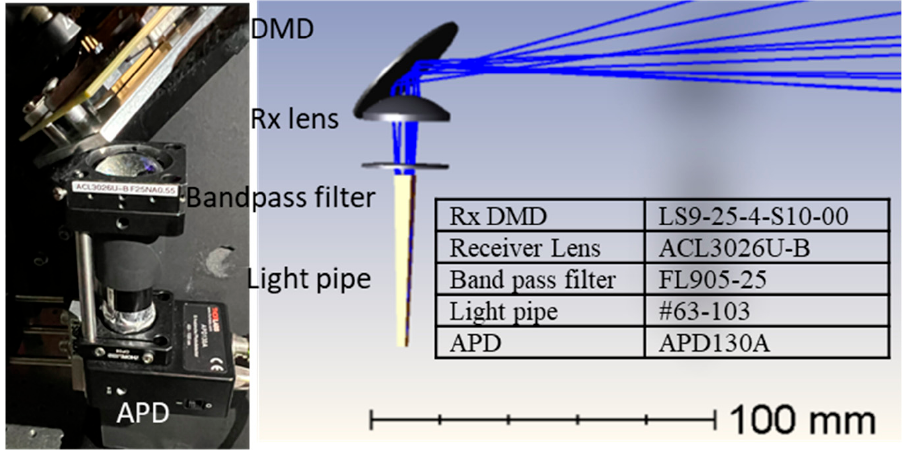
Figure 4. Photograph ( left ) and a ray-tracing diagram of the lidar receiver ( right ).